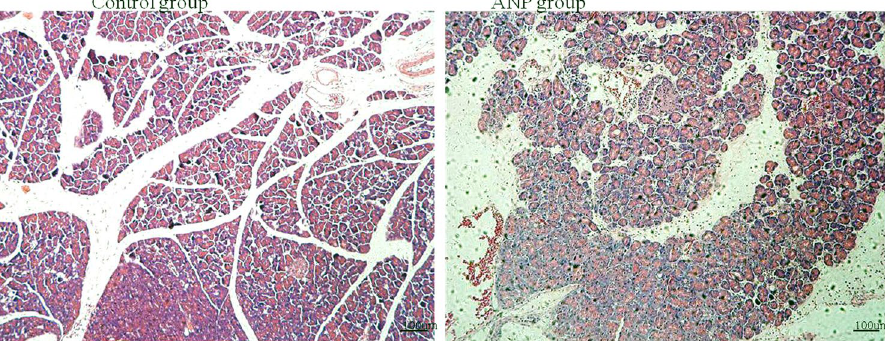
Figure 1. Representative H&E-stained sections of the pancreas. Pancreas sections from the control mice and the mice with ANP. The original magnification is